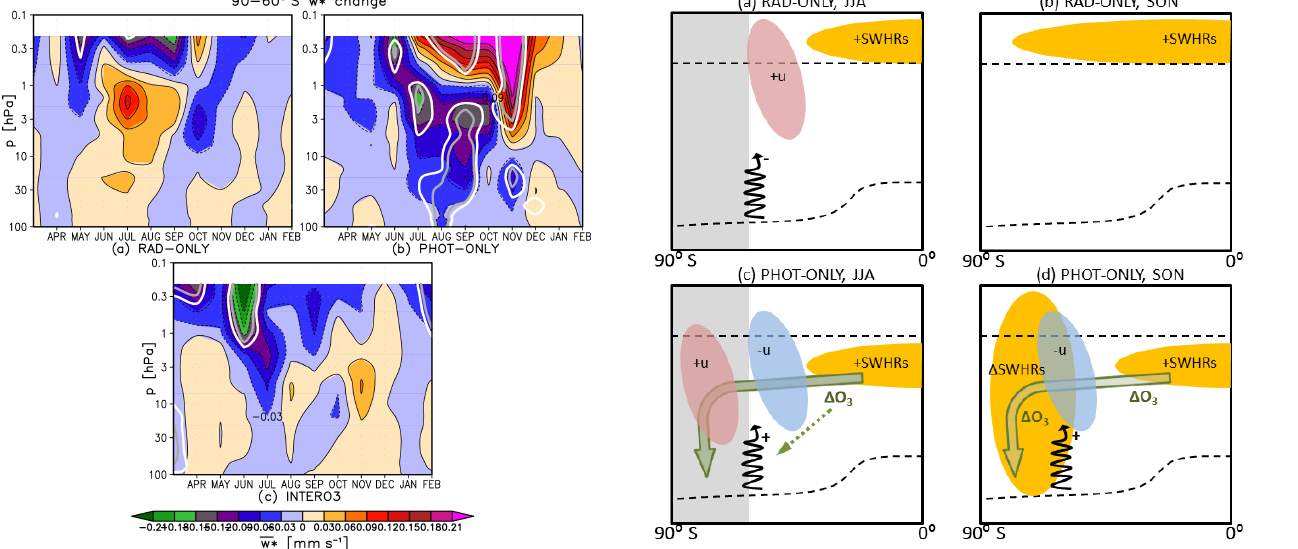
Figure 9. The monthly mean evolution of the polar cap average (90–60 ◦ S) change in the vertical component of the transformed Eu- lerian mean circulation, w ∗ (mms − 1 ), between SMAX and SMIN for (a) RAD-ONLY, (b) PHOT-ONLY and (c) INTERO3. Positive values indicate anomalous upwelling and vice versa. Thick white and grey lines indicate statistical significance at the 90% and 95% confidence level, respectively.